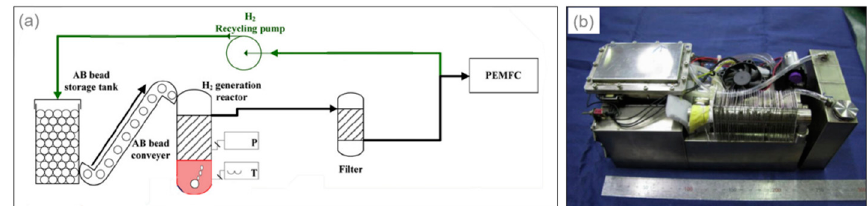
Figure 13. Hydrogen generator developed by Kim et al. [237]. ( a ) A process flow diagram of the continuous hydrogen generator from ammonia borane: the ammonia borane beads are conveyed into the tetraethylene glycol dimethyl ether-containing reactor; the generated hydrogen is filtered and then it feeds a polymer electrolyte membrane fuel cell (PEMFC); the excess of hydrogen is recycled. ( b ) Photography of the hydrogen generator. Reprinted from ref. [237], Copyright (2013), with permission from Elsevier.